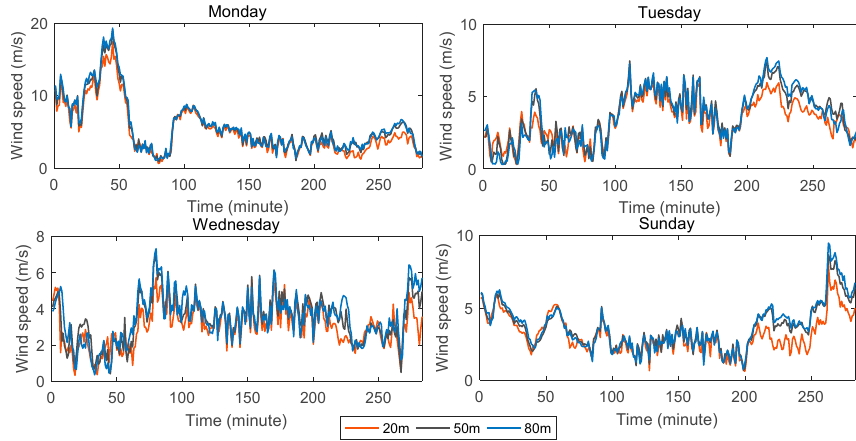
Figure 4. Observations of wind speed at different heights. Table 1. The results of hard threshold and soft threshold de-noising.